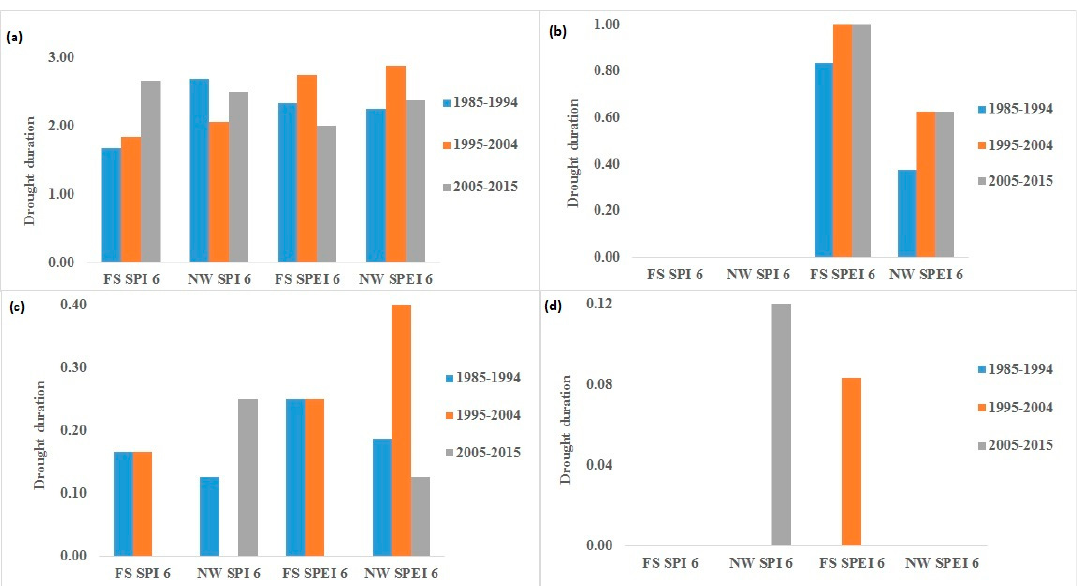
Figure 11. Drought duration (measured in months) based on SPI and SPEI 6 indices: ( a ) mild drought; ( b ) moderate drought; ( c ) severe drought; and ( d ) extreme drought.